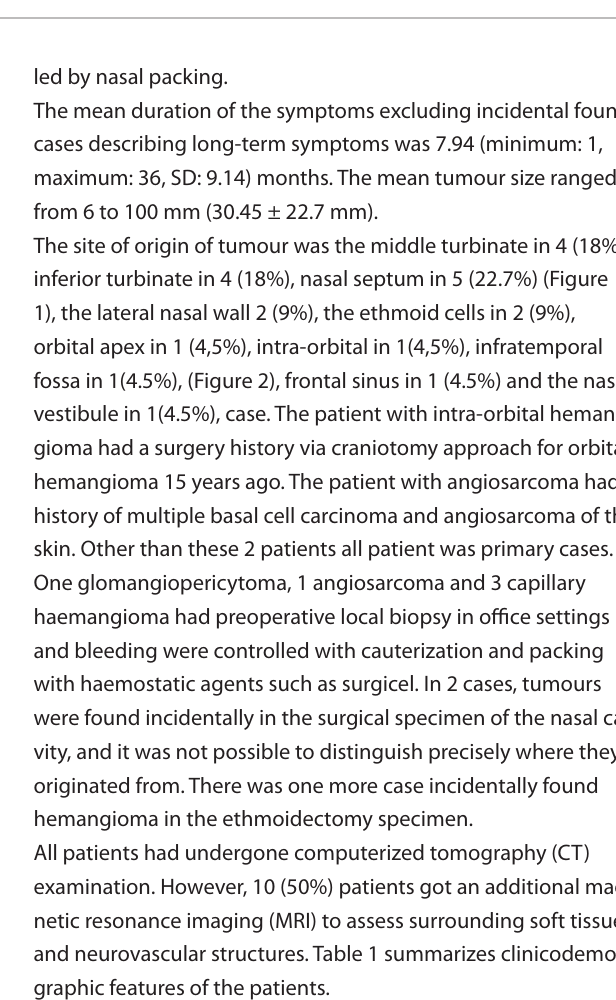
Figure 1. Preoperative a) coronal CT and b) sagittal MRI of the patient with nasal septum anterior originated lobullary capillary hemangioma (LCH) causing septal perforation c) endoscopic view of LCH d) Intraoperative view of septal perforation after complete resection S: nasal septum, *